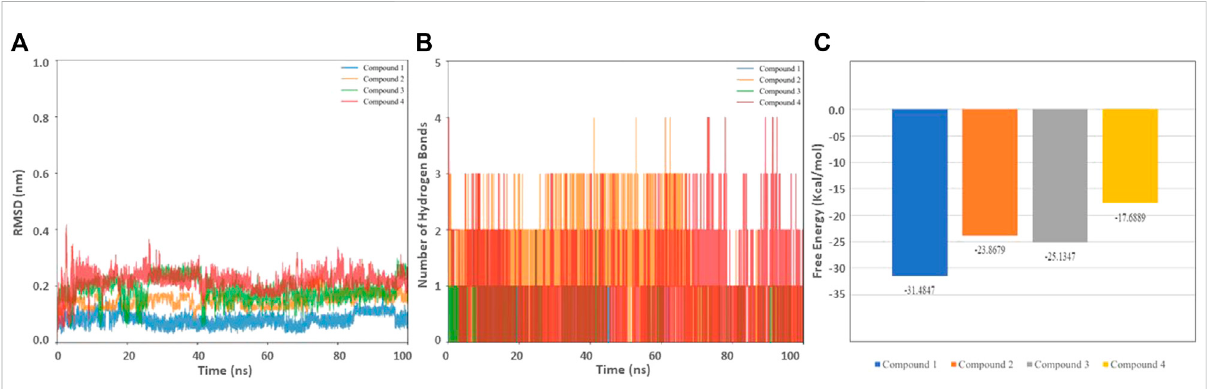
FIGURE 5 Biophysicalsimulationanalysisofthecomplexes. (A) RMSDplotofHSP90withtheidenti fi edcompounds (B) Hydrogenbondfrequencyplot (C) Binding free energy.